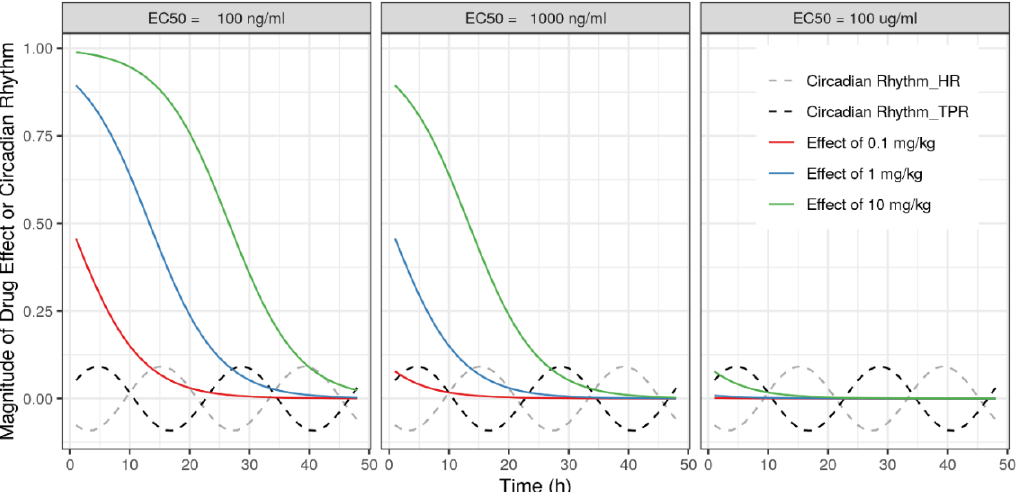
Figure 6. Comparison of magnitudes of circadian rhythm on HR or TPR and magnitudes of drug effect. Comparison of EC 50 as 100 ng/mL ( left ), 1000 ng/mL ( middle ), and 100 ug/mL ( right ). Dark blue solid line: drug effect following a dose of 0.1 mg/kg; orange solid line: drug effect following a dose of 1 mg/kg; green solid line: drug effect following a dose of 10 mg/kg; black dashed line: magnitude of circadian rhythm effect of HR; gray dashed line: circadian rhythm effect of